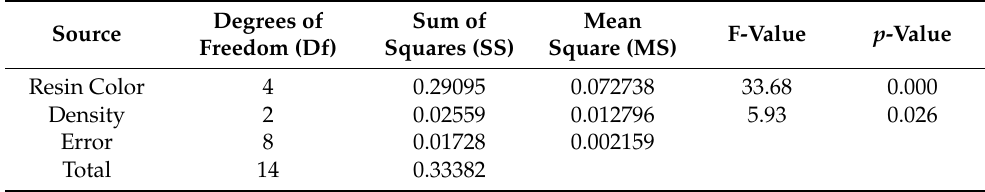
Table 11. Analysis of variance for